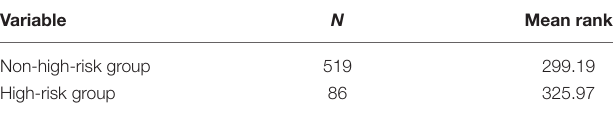
TABLE 3 | Rank mean scores of accommodation in crisis intervention cell. Variable N Mean rank Non-high-risk group 519 299.19 High-risk group 86